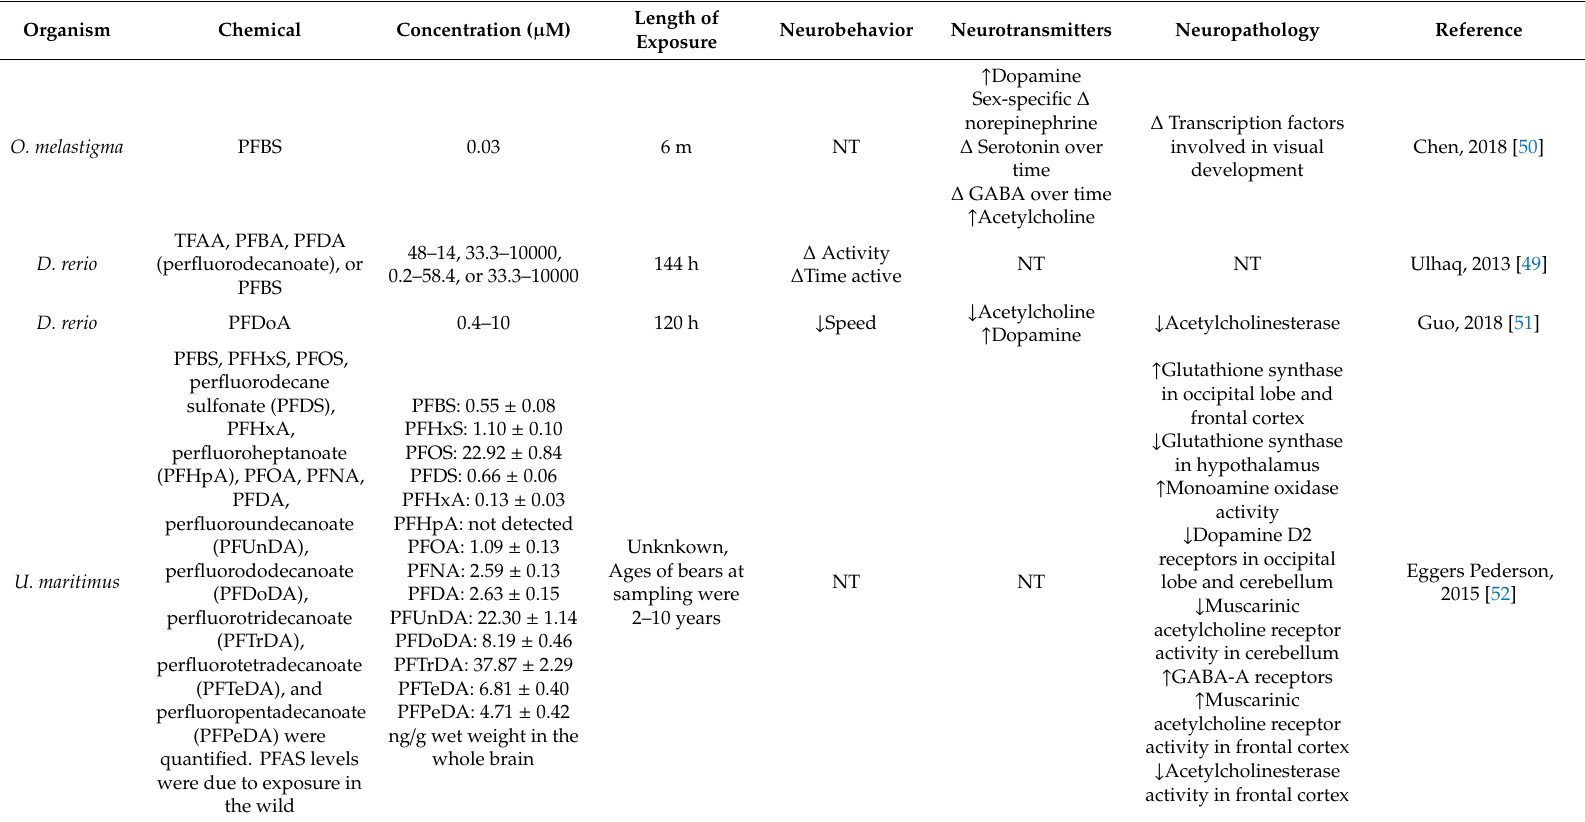
Table 3. Other PFAS neurotoxicity endpoints and findings in species where neurological endpoints were tested. NT = not tested. ∆ —indicates a change after exposure that is not consistent over dose or time, i.e., nonmonotonic dose